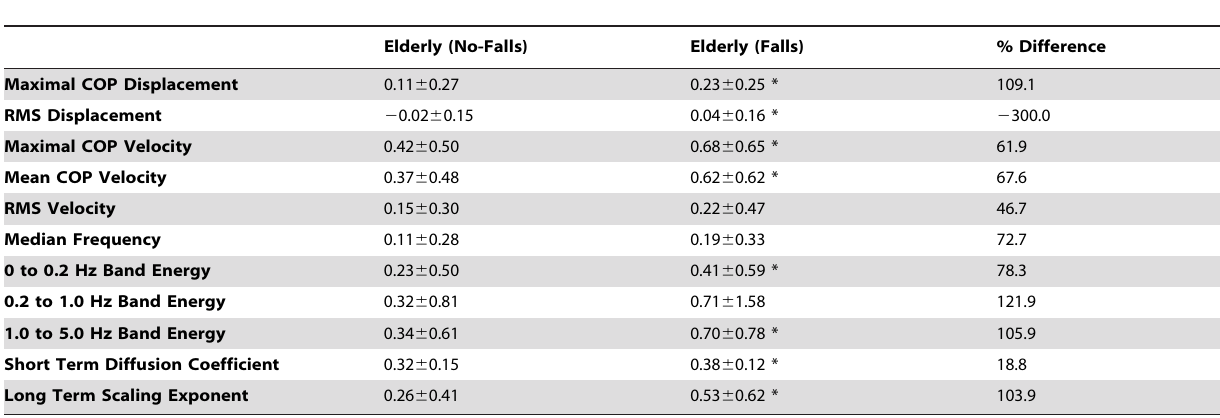
Table 3. Z-Scores for Elderly , with and without a recent history of